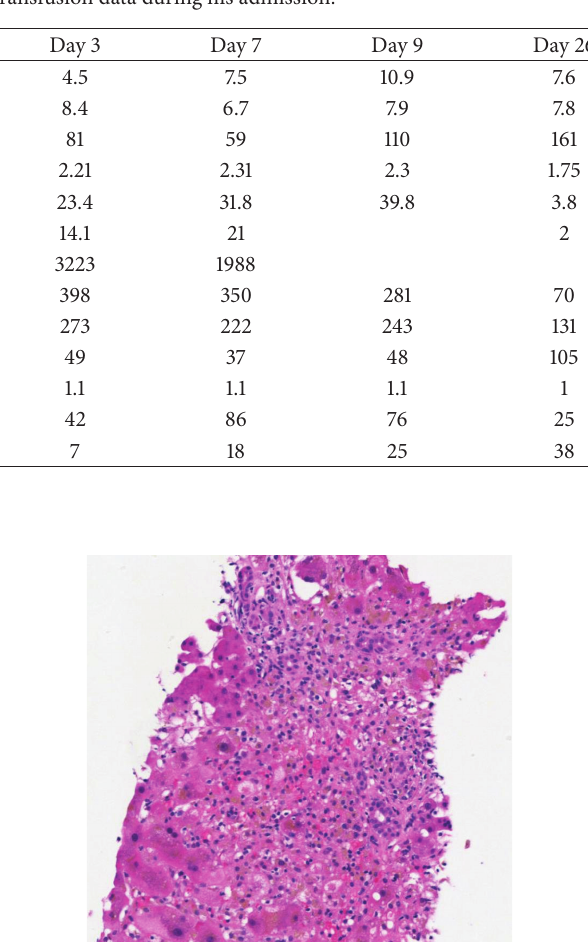
Table 1: Trend in patient’s laboratory and transfusion data during his admission.